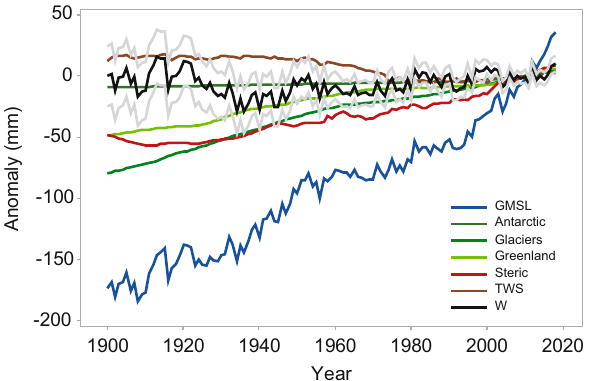
Figure 8: The yearly averaged anomalies of GMSL budget compo - nents with their 1 SE uncertainties. The yearly misclosures are shown with their uncertainties in gray color.